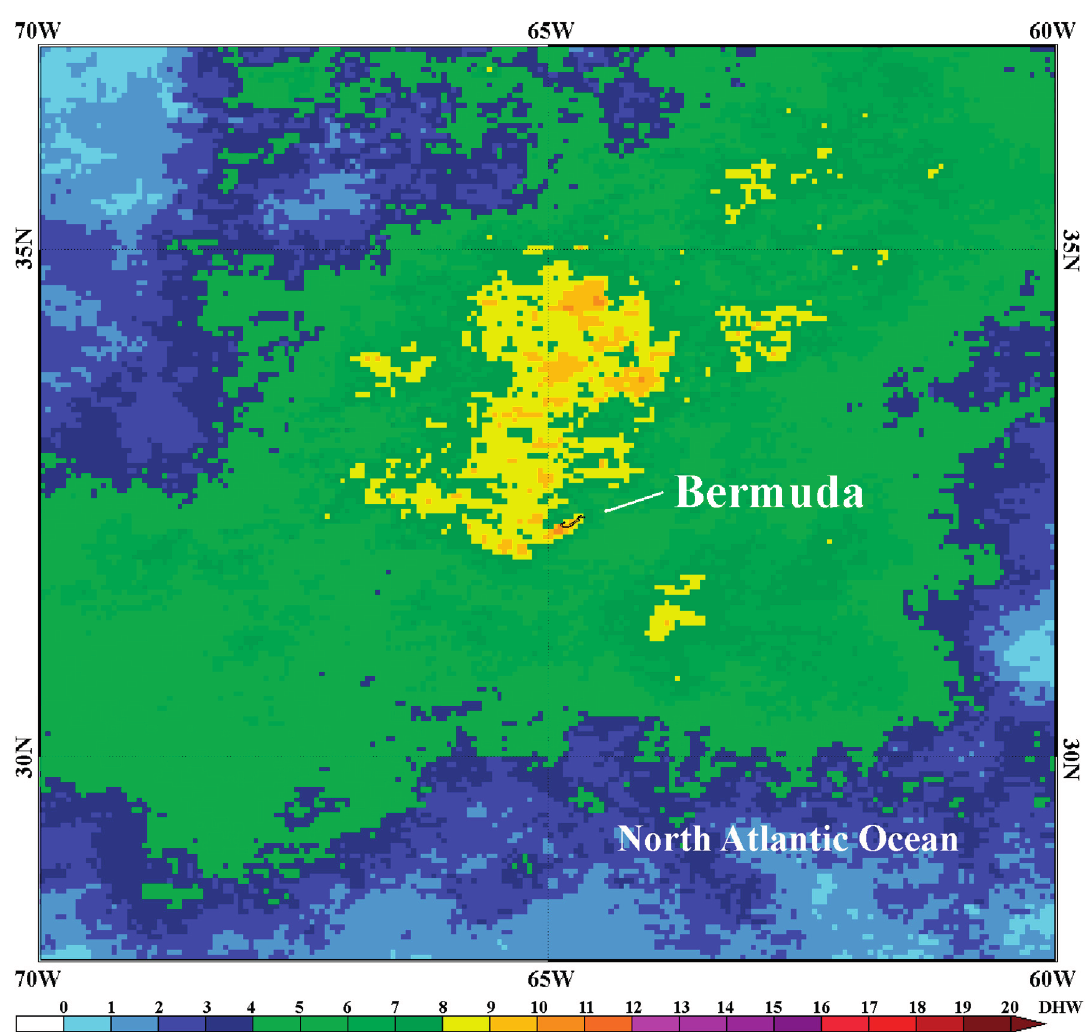
Figure 10. CRW’s daily 5-km regional DHW image for Bermuda on 28 August